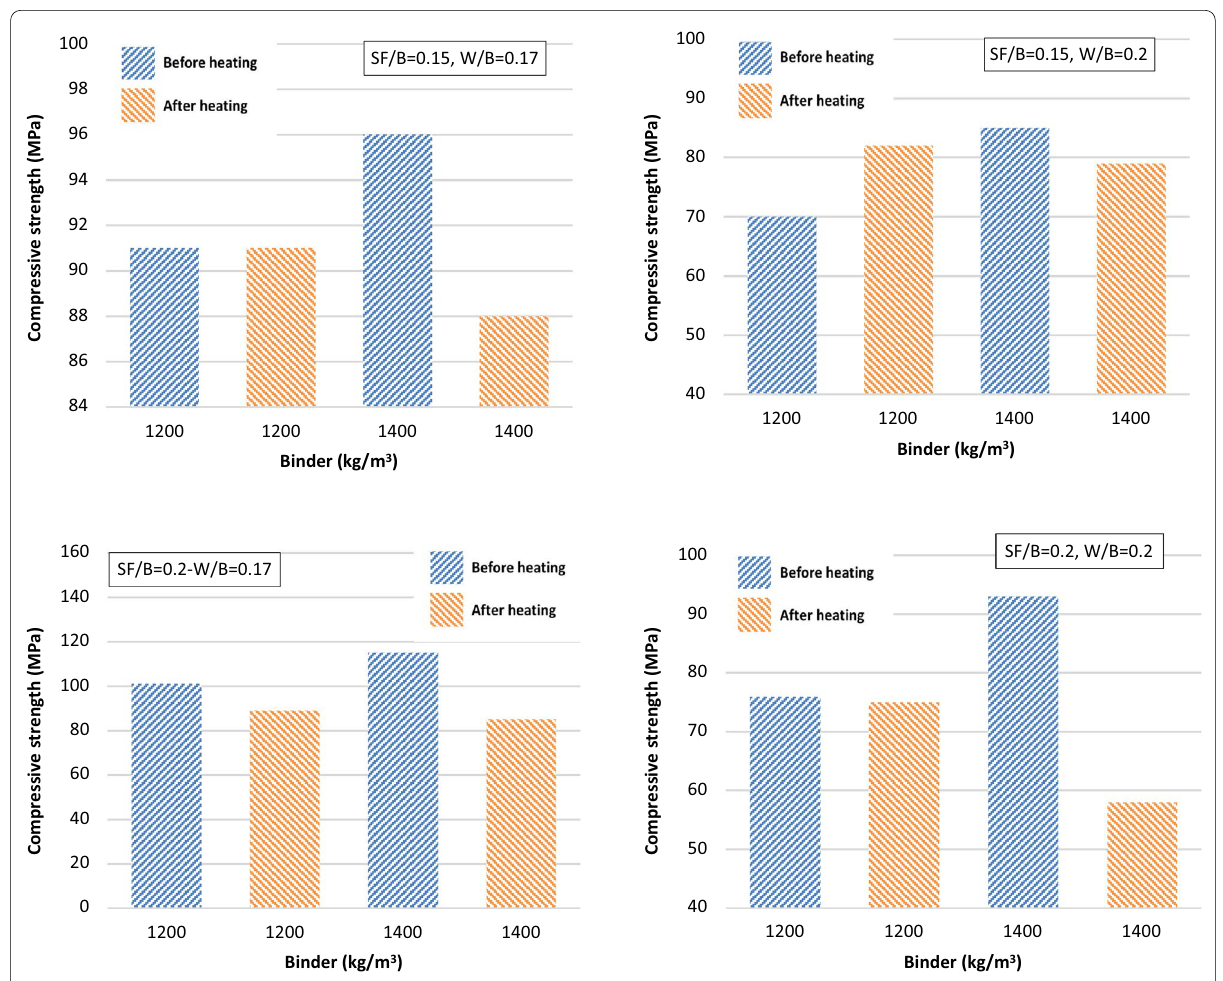
Fig. 9 Variations of compressive strength of concrete mixes against binder content before and after